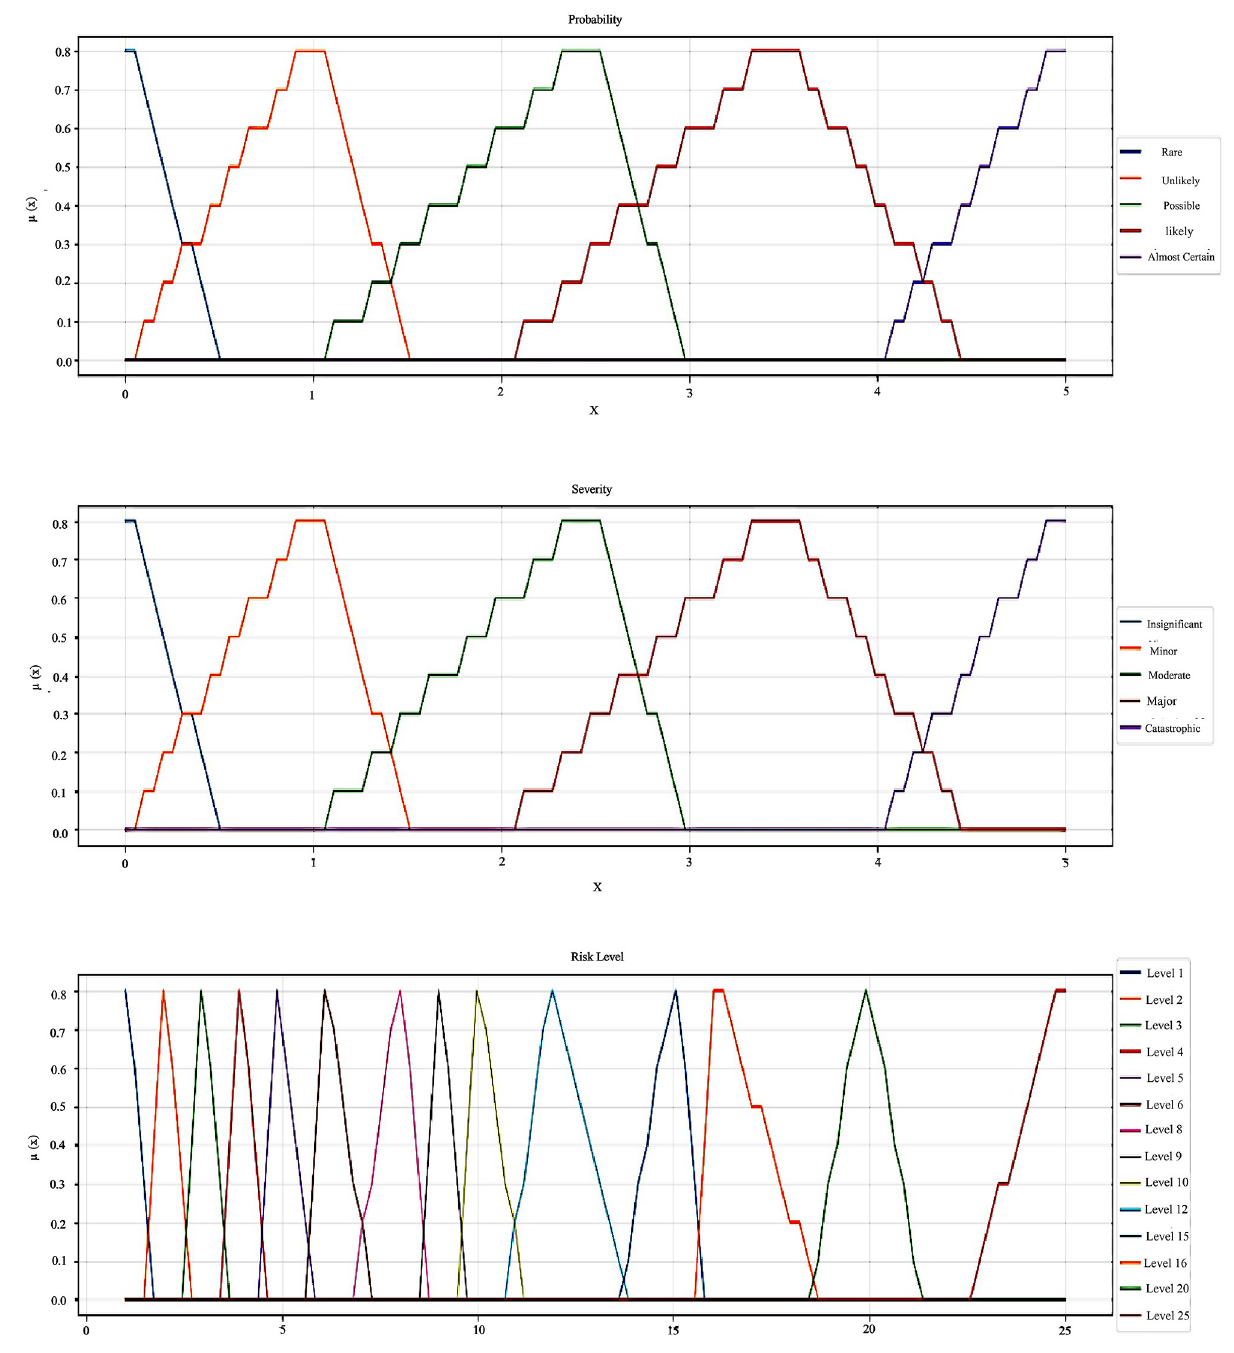
Fig 4. The membership curve plots of TIFNs for two input variables: Severity and probability and the output variable: Risk level.